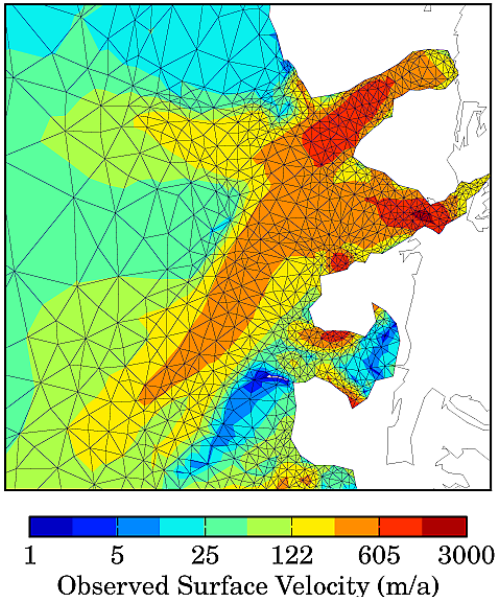
Fig. 1. Observed surface velocity projected onto an anisotropically refined mesh of Greenland’s northeast ice